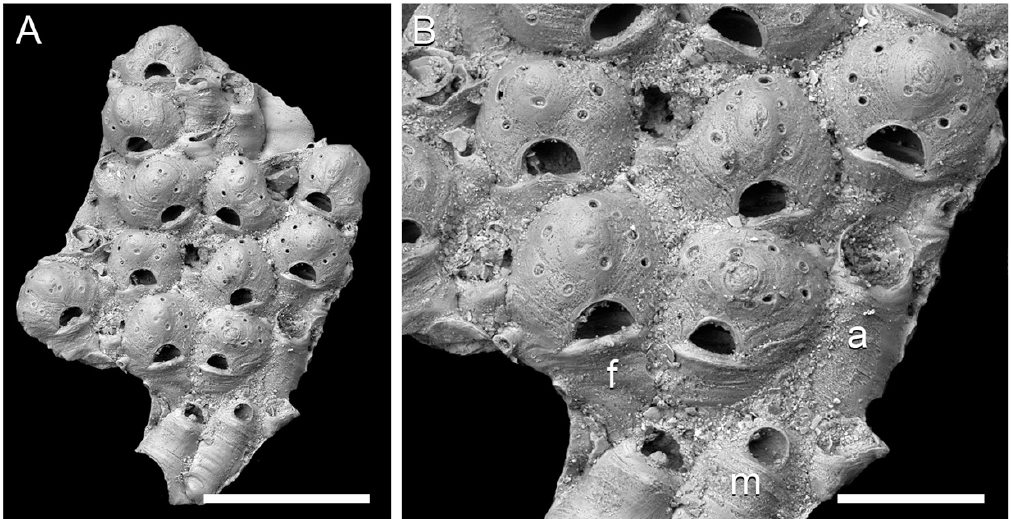
Figure 4. Celleporella hyalina (Linnaeus, 1767) from the Clyde Clay Formation of Garvel Park, Greenock, Scotland, NHMUK D1645; ( A ) colony fragment; ( B ) detail with examples of an autozooid (a), female zooid (f) and male zooid (m) labelled. Scale bars: A = 500 µm; B = 200 µm.